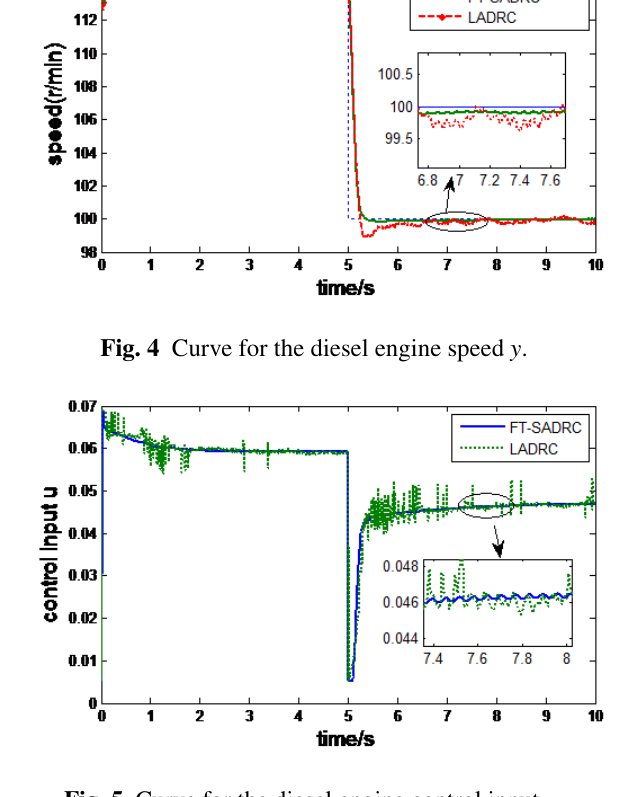
Fig. 5 Curve for the diesel engine control input u